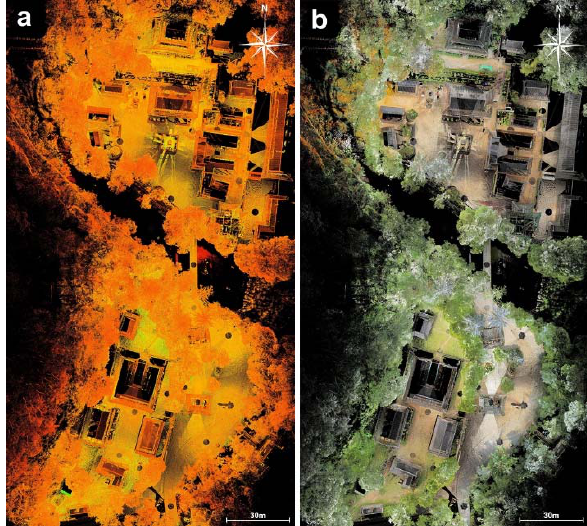
Figure 4. Orthoimage of the Magoksa Temple created by terrestrial laser scanning: (a) Point cloud image; (b) Texture mapping image